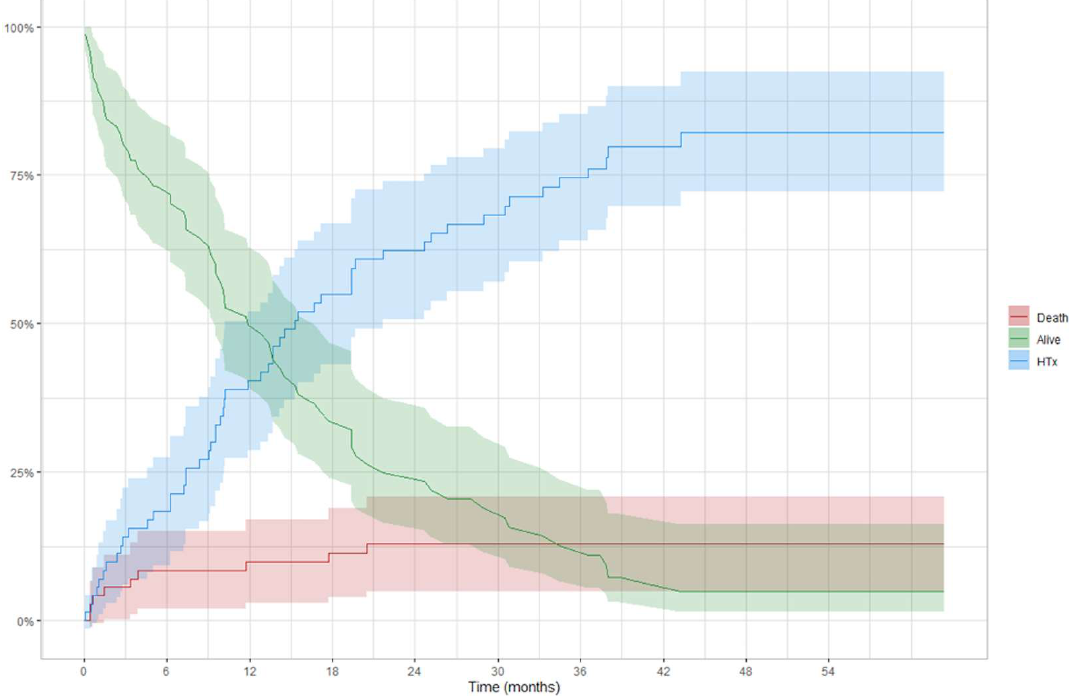
Figure 4. Kaplan–Meier analysis of survival among INTERMACS Profile 1–3 and Profile 4 BTT patients.